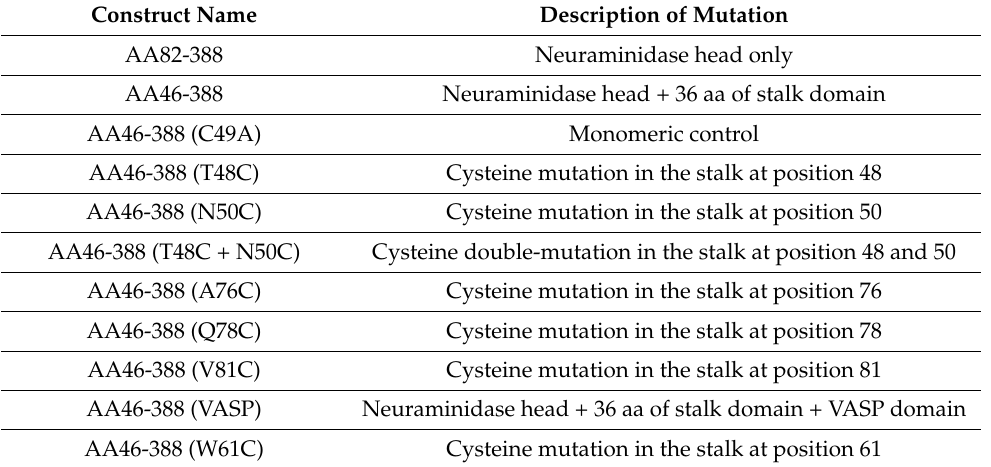
Table 1. Description of N1 mutant